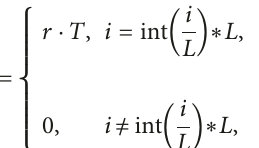
Table 4: Performance of the three boxplots with T